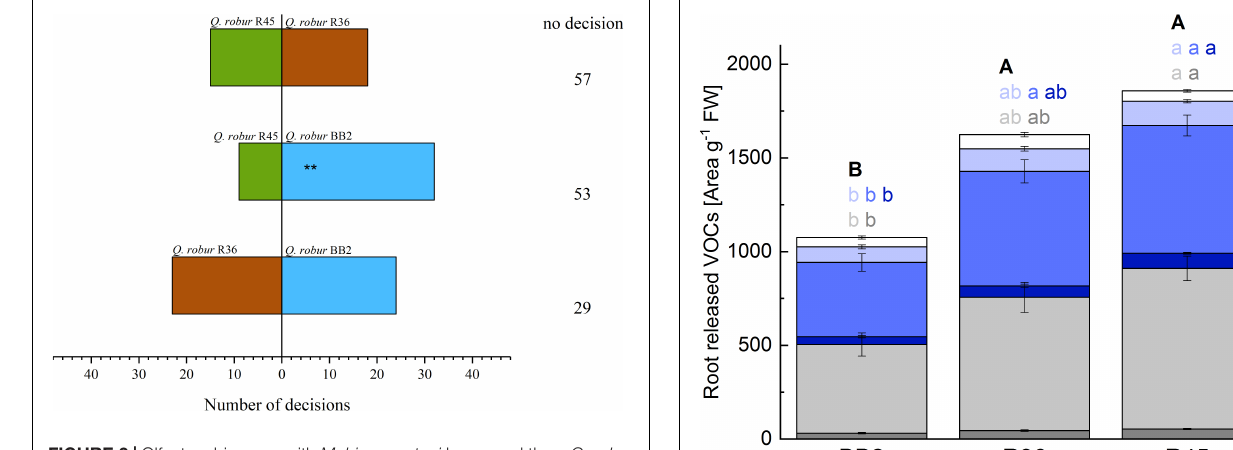
FIGURE 2 | Olfactory bioassay with M. hippocastani larvae and three Q. robur populations. Two trees, one of two populations each, were tested against each other. Each of the three possible combinations was planted 10 times. Individual larvae were placed in the central inlet of the bioassay system for 12 h. Data are total numbers of animals selecting specific trees, or with no decision. Statistically significant differences were calculated with the Wilcoxon